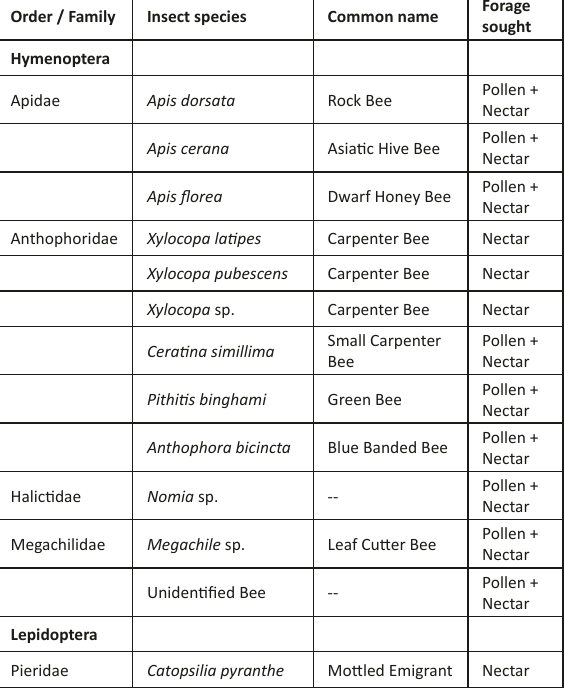
Table 2. List of insect foragers on Derris trifoliata